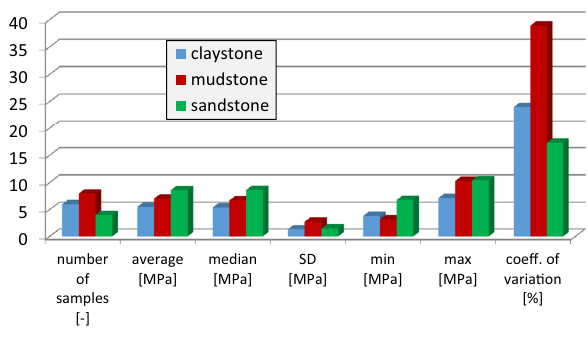
Fig. 6 Comparison of chosen statistical parameters for tensile strength data